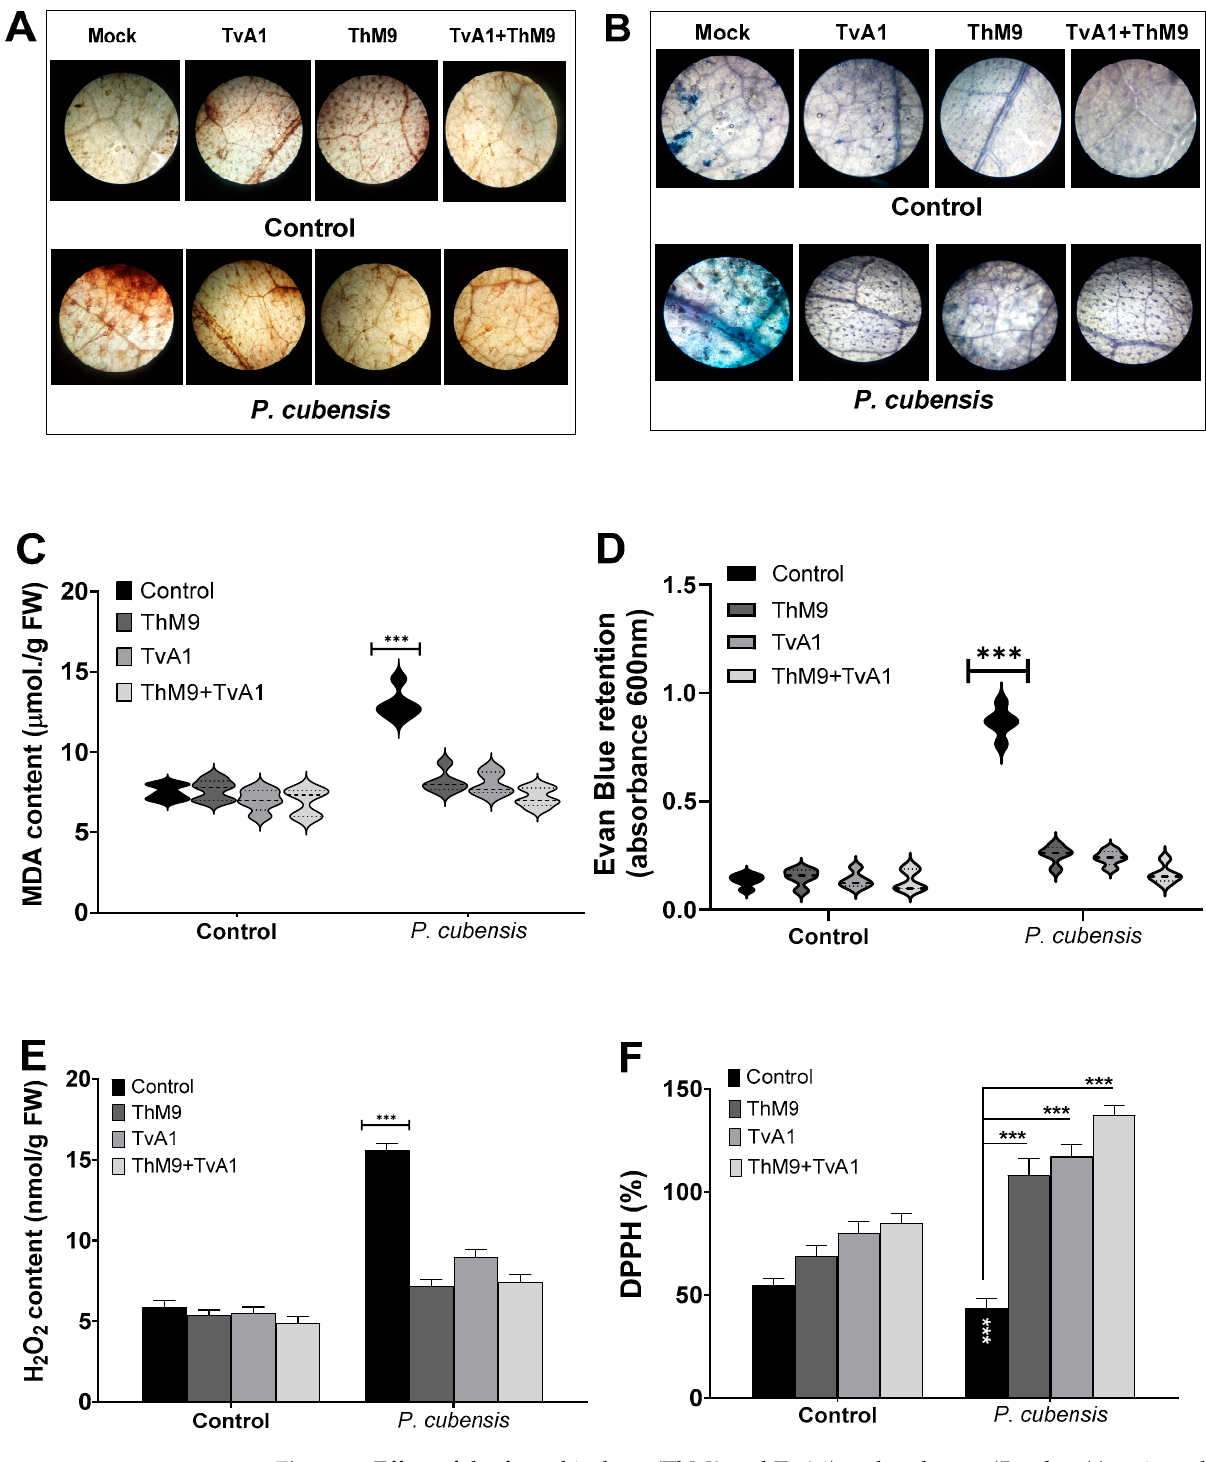
Figure 6. Effect of the fungal isolates (ThM9 and TvA1) and pathogen ( P. cubensis ) co-inoculation on oxidative status and antioxidant potential in luffa leaf. ( A ) DAB staining. ( B ) Evan blue staining. ( C ) MDA content. ( D ) Retention of Evan blue. ( E ) H 2 O 2 content. ( F ) DPPH (%). Quantitative data represent the means ± SD (n = 12) of three independent experiments. The asterisks indicate a significant difference between treated samples compared to control (*** p ≤ 0.005). FW, fresh weight.